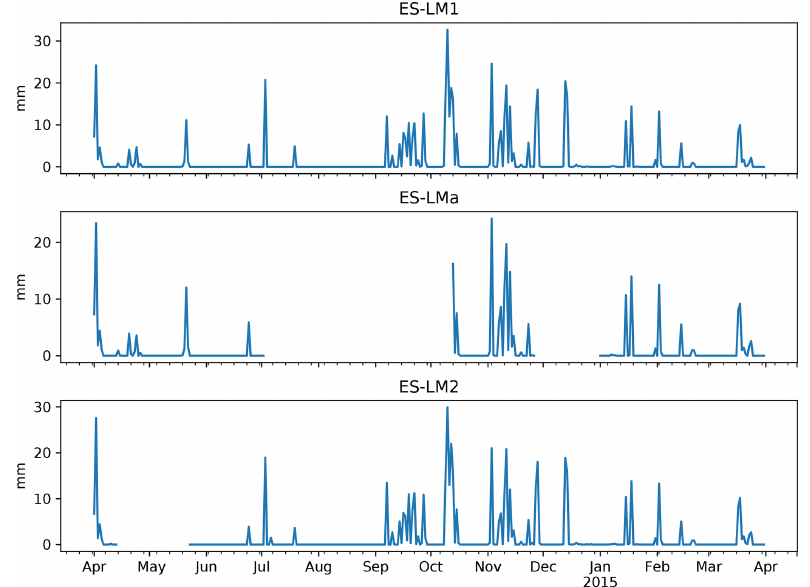
Figure A9. Daily aggregated precipitation in Majadas de Tiètar measured at the three tower sites from April 2014 to March 2015. Missing values are plotted as gaps.